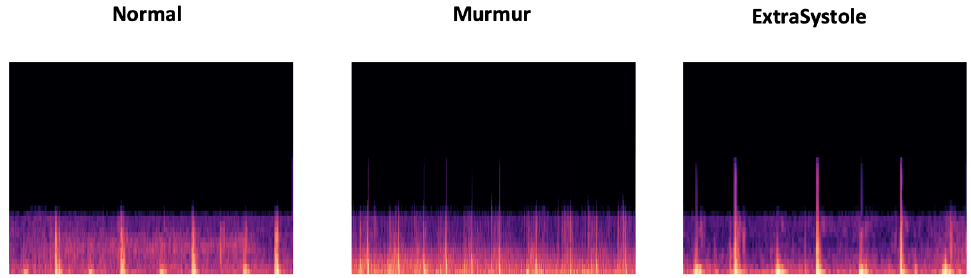
Figure 5. Overview of extrasystole-mumur-normal MFCC features represented in PNG images.